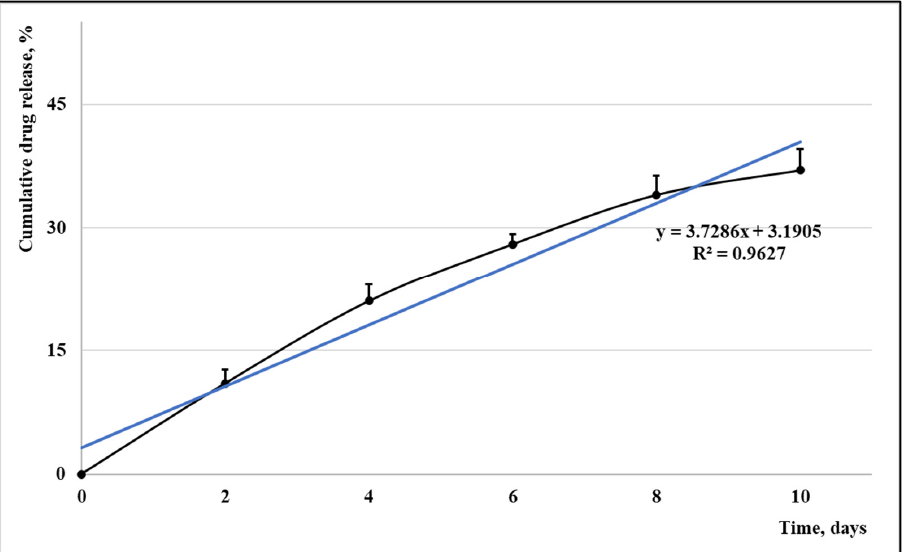
Figure 2. The release profile of Cc from sample PU_Cc.